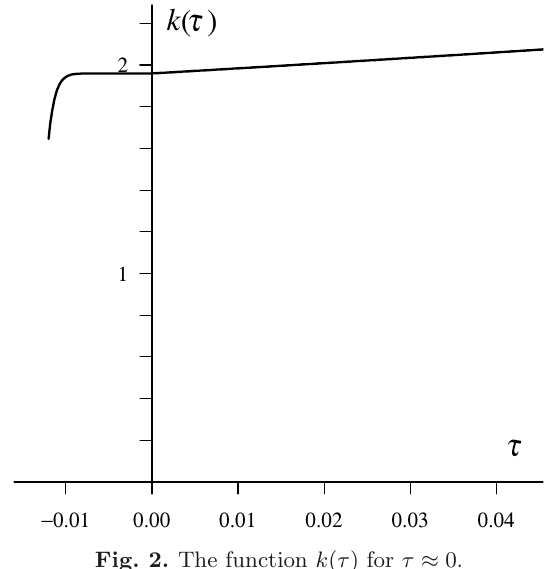
Fig. 2. The function k ( τ ) for τ ≈